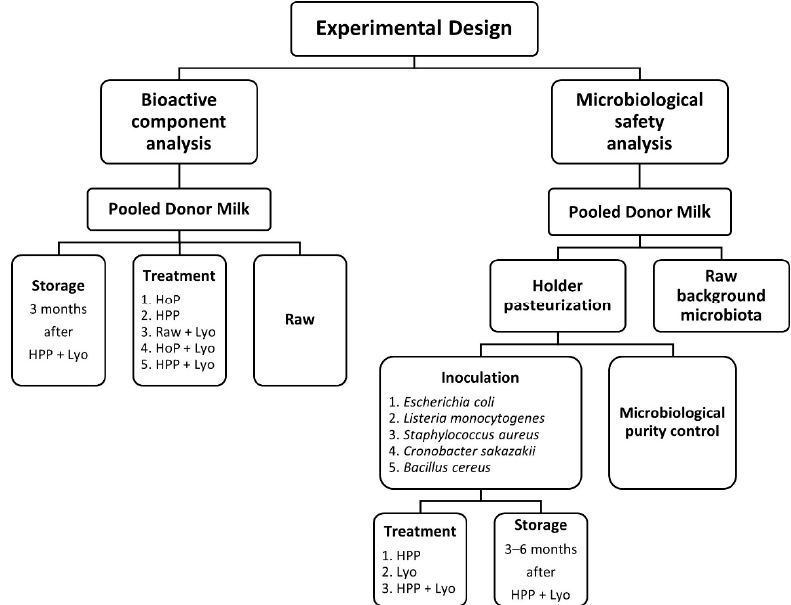
Figure 1. Experimental design including the analyses of bioactive components and microbiological safety in raw, treated, and stored human milk samples.